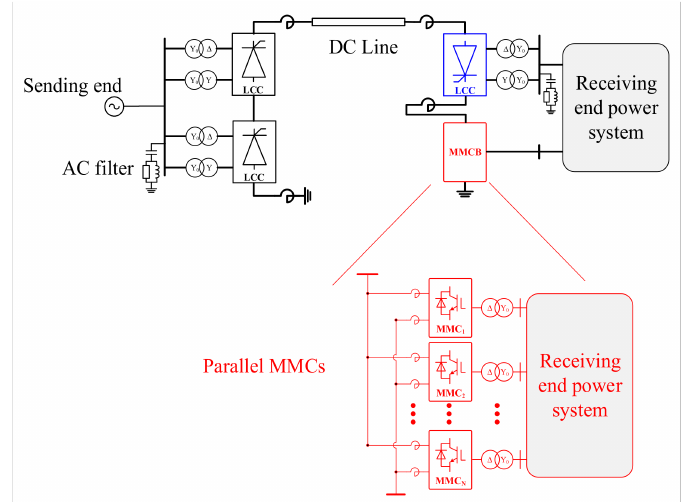
Figure 1. Unipolar topology of decentralized hybrid systems with a line commutated converter (LCC) rectifier and line commutated converter-modular multilevel converter (LCC-MMC) cascaded